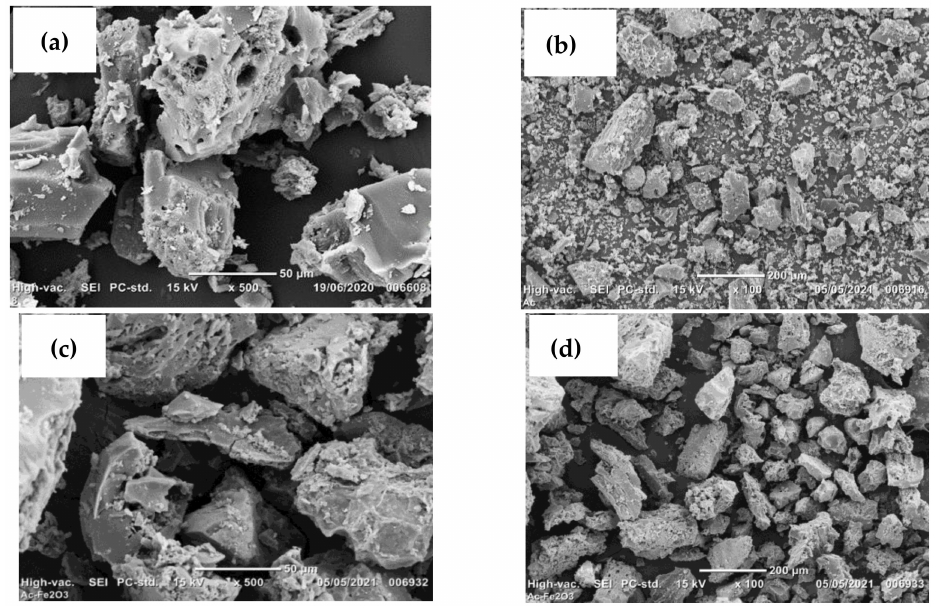
Figure 2. SEM images of different adsorbents based on activated carbon. ( a , b ), AC; ( c , d ),